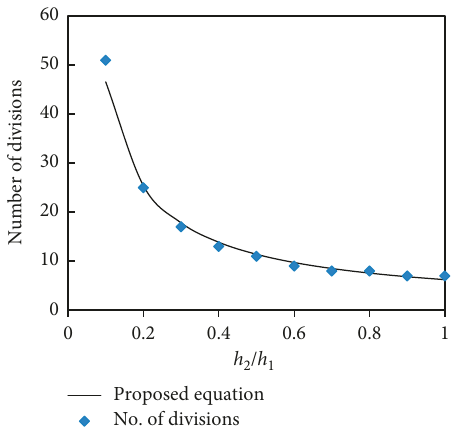
Figure 5: Proposed equation for prediction the required number of integral divisions.